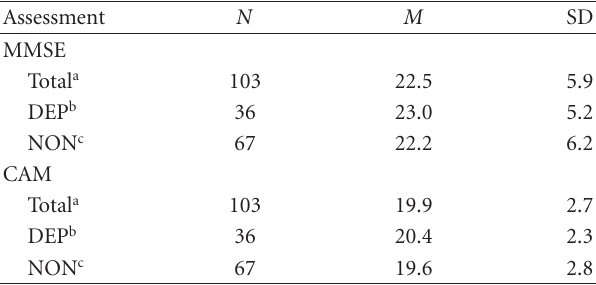
Table 2: Descriptive statistics for total and subgroup CAM and MMSE scores.